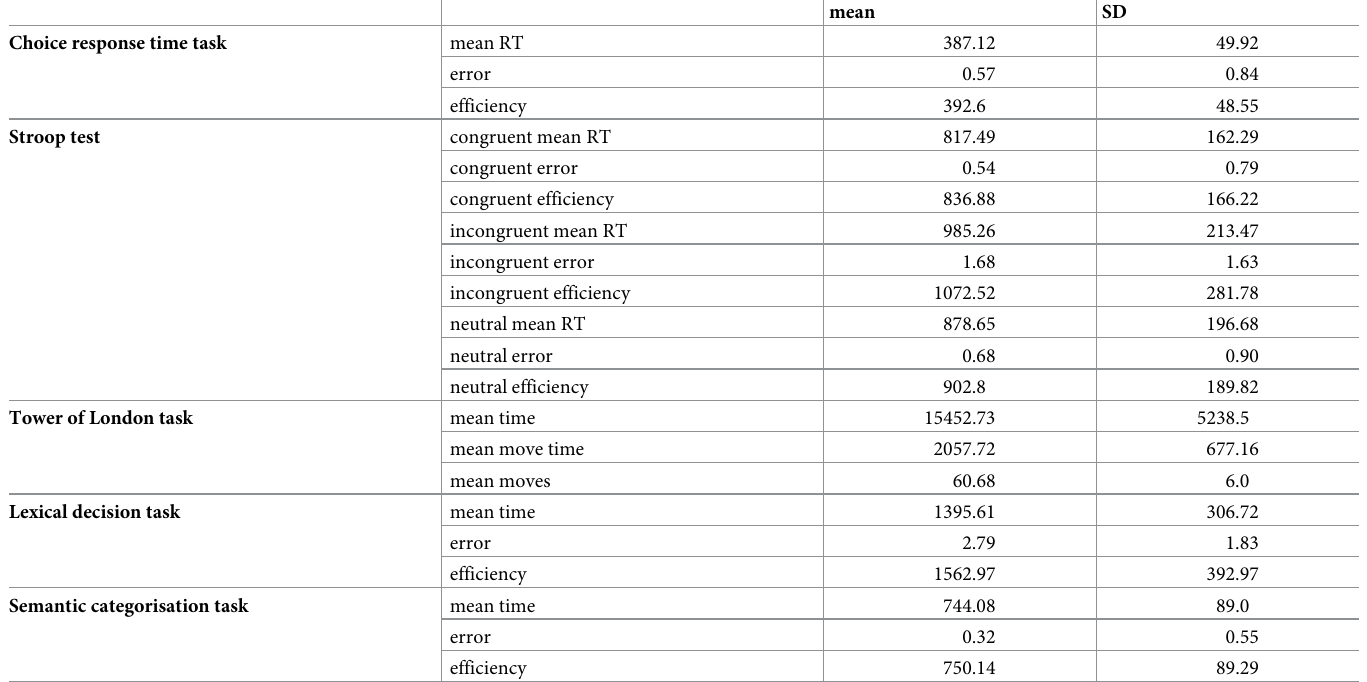
Table 2. Means and standard deviations of cognitive